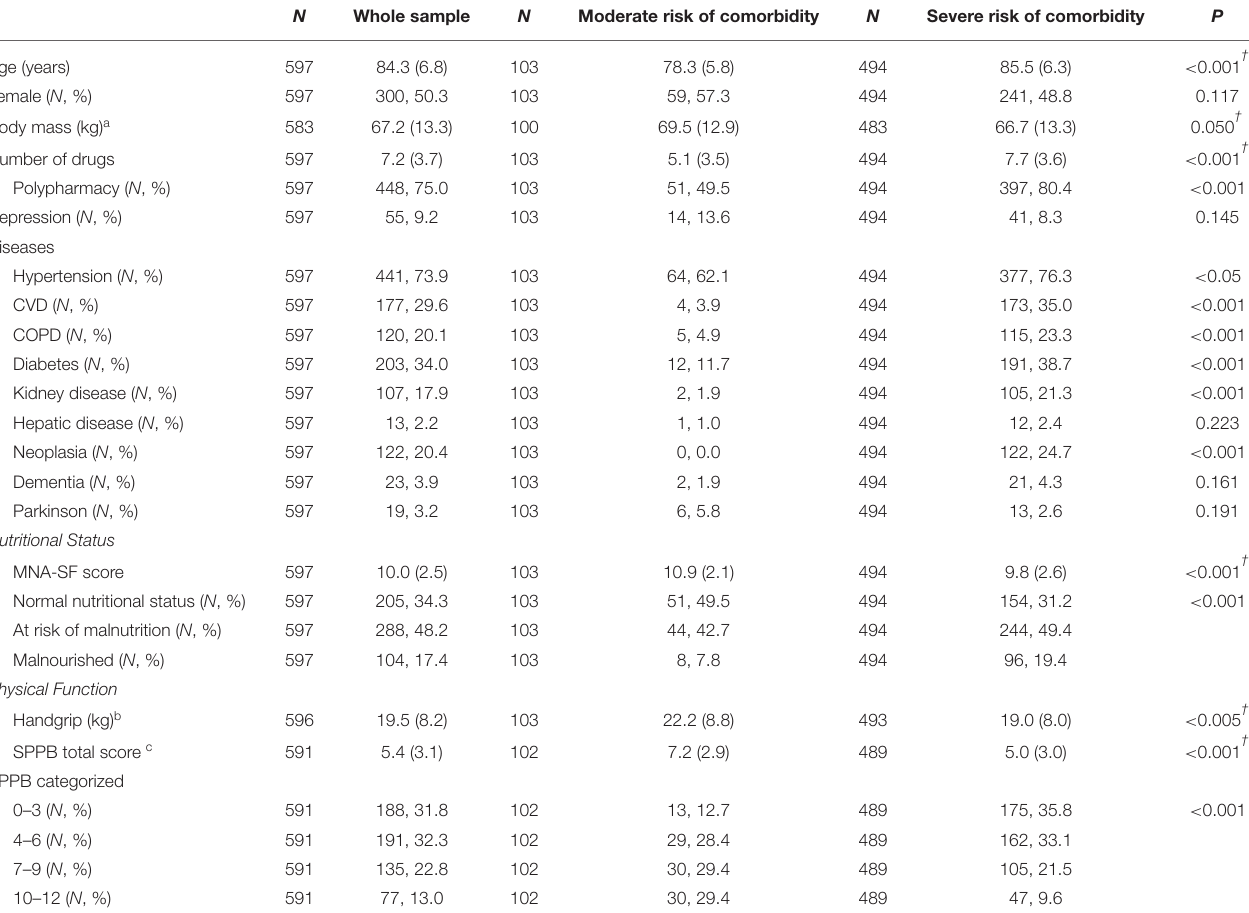
TABLE 1 | Characteristics of participants in the study by comorbidity risk according to the Charlson Comorbidity Index (CCI). N Whole sample N Moderate risk of comorbidity N Severe risk of comorbidity